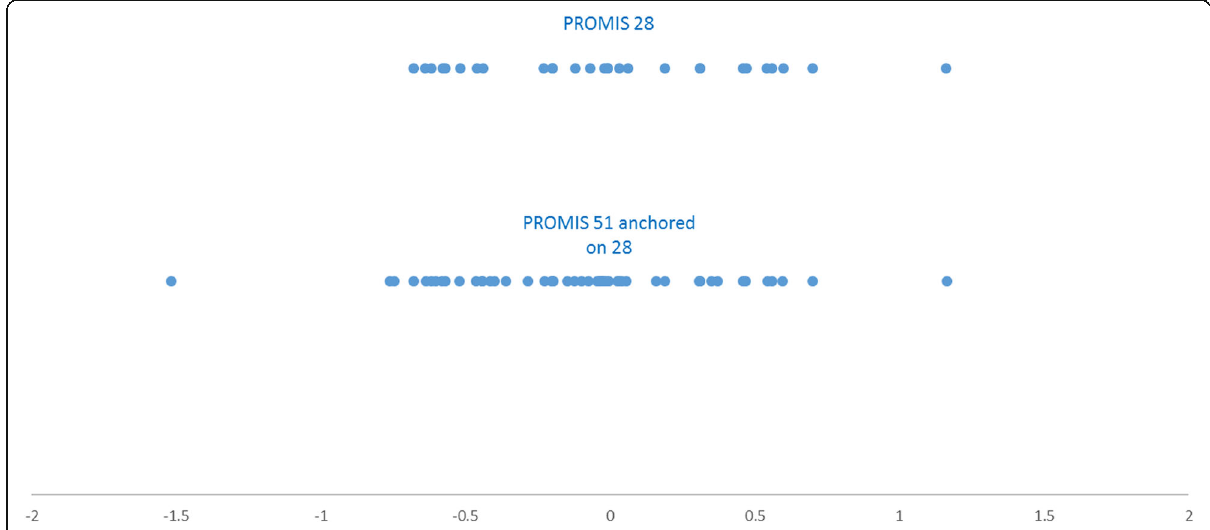
Fig. 2 Plot of relative items location of the PROMIS 51 and 28 item pools. The blue dots represent the item locations for each item within the PROMIS 28 and PROMIS 51 (as anchored on the PROMIS-28 measurement continuum) item banks. The items located on the left of the continuum are the easiest (i.e. are relevant to persons with lower levels of depression); items towards the right are the most difficult (i.e. are relevant to person with higher levels of depression). The PROMIS 51 items cover parts of the continuum (< − 0.75) and around ( − 0.50 to 0.00) where the PROMIS 28 item distribution displays item gaps, as well as smaller gaps of the 28-item pool along the